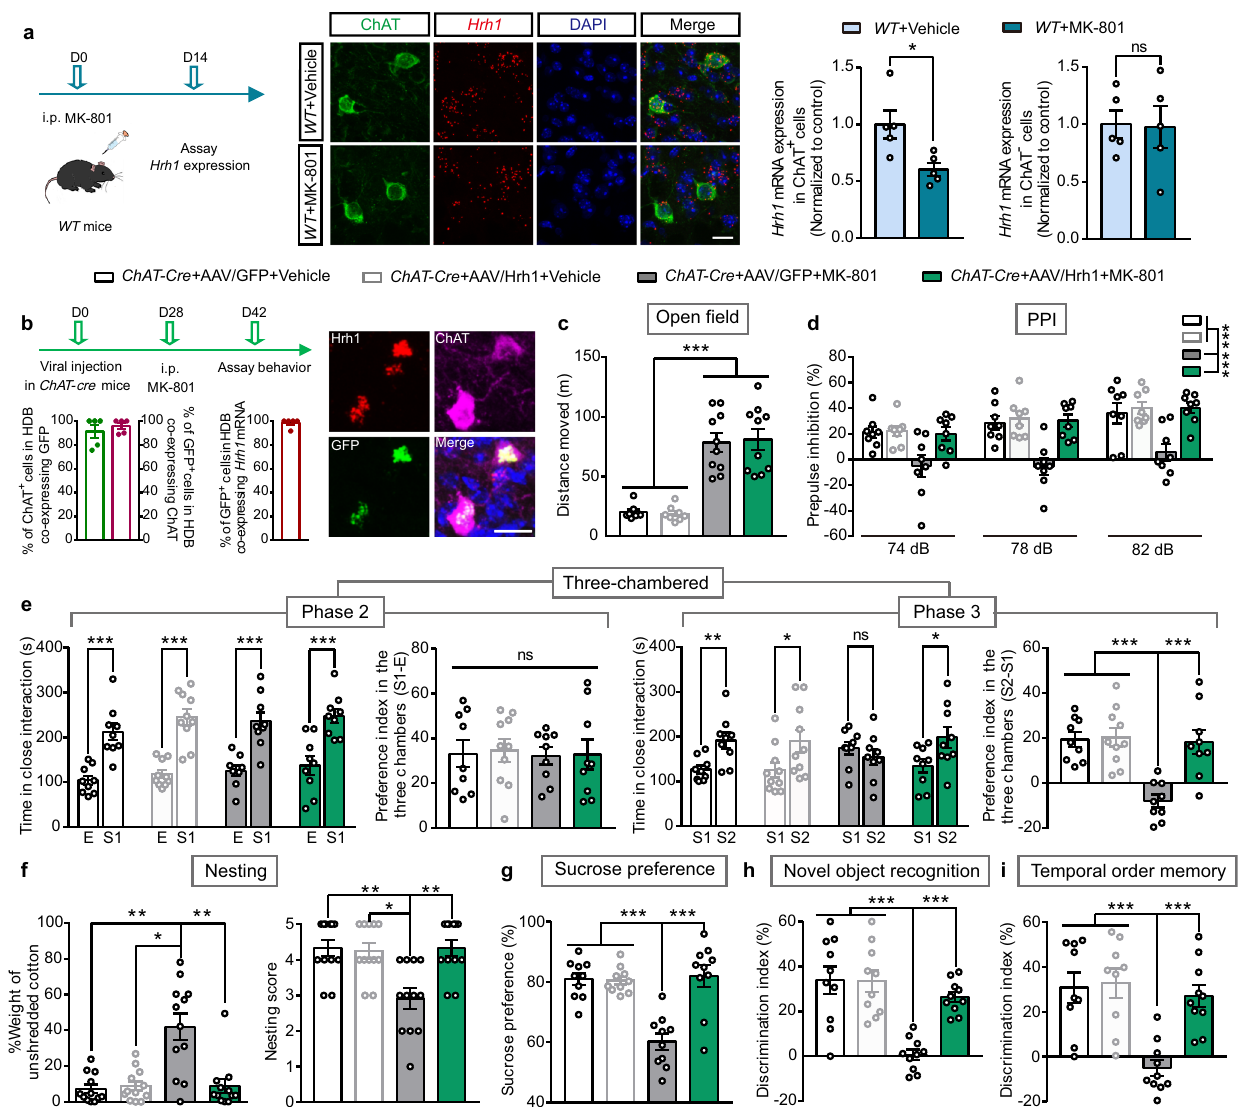
Fig. 7 Over-expression of histamine H 1 R in BF cholinergic neurons selectively rescues sensorimotor gating ability de fi cit, social impairments, anhedonia-like behavior, and cognitive impairments, but not hyperlocomotion after MK-801 exposure. a Schedule of 2-week MK-801 injections